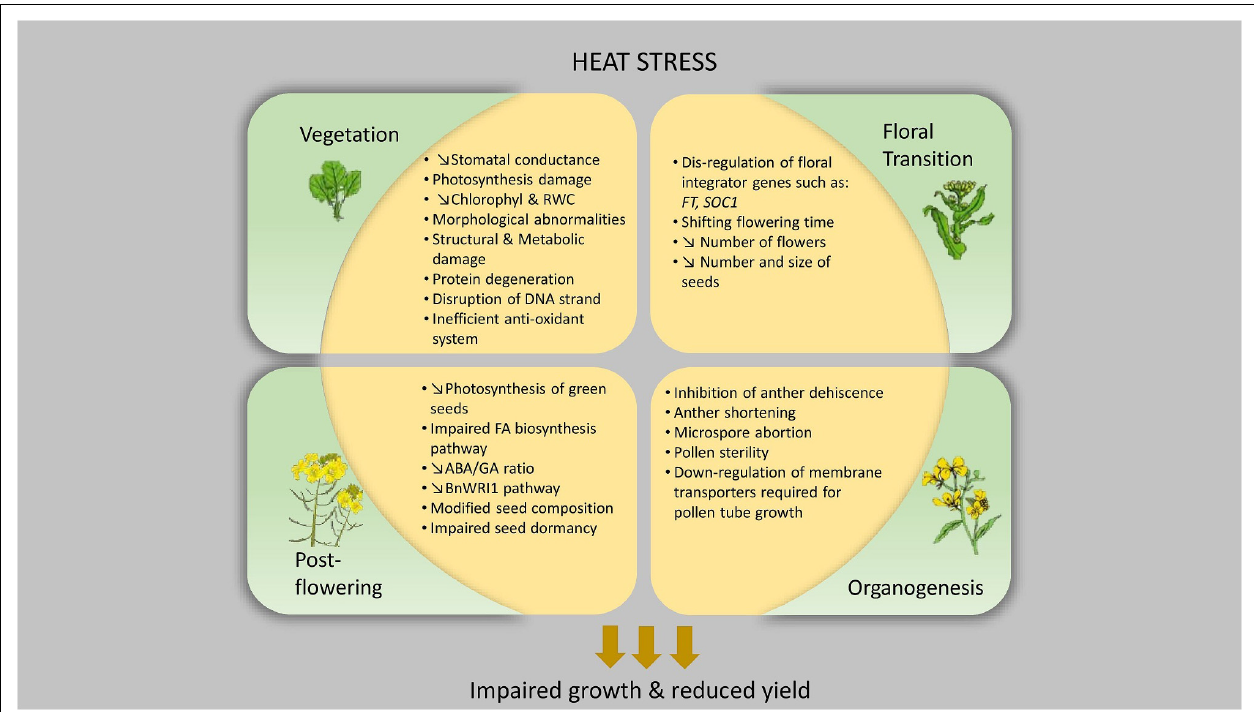
FIGURE 1 | Physiological impact of heat stress at different developmental stages of Brassica